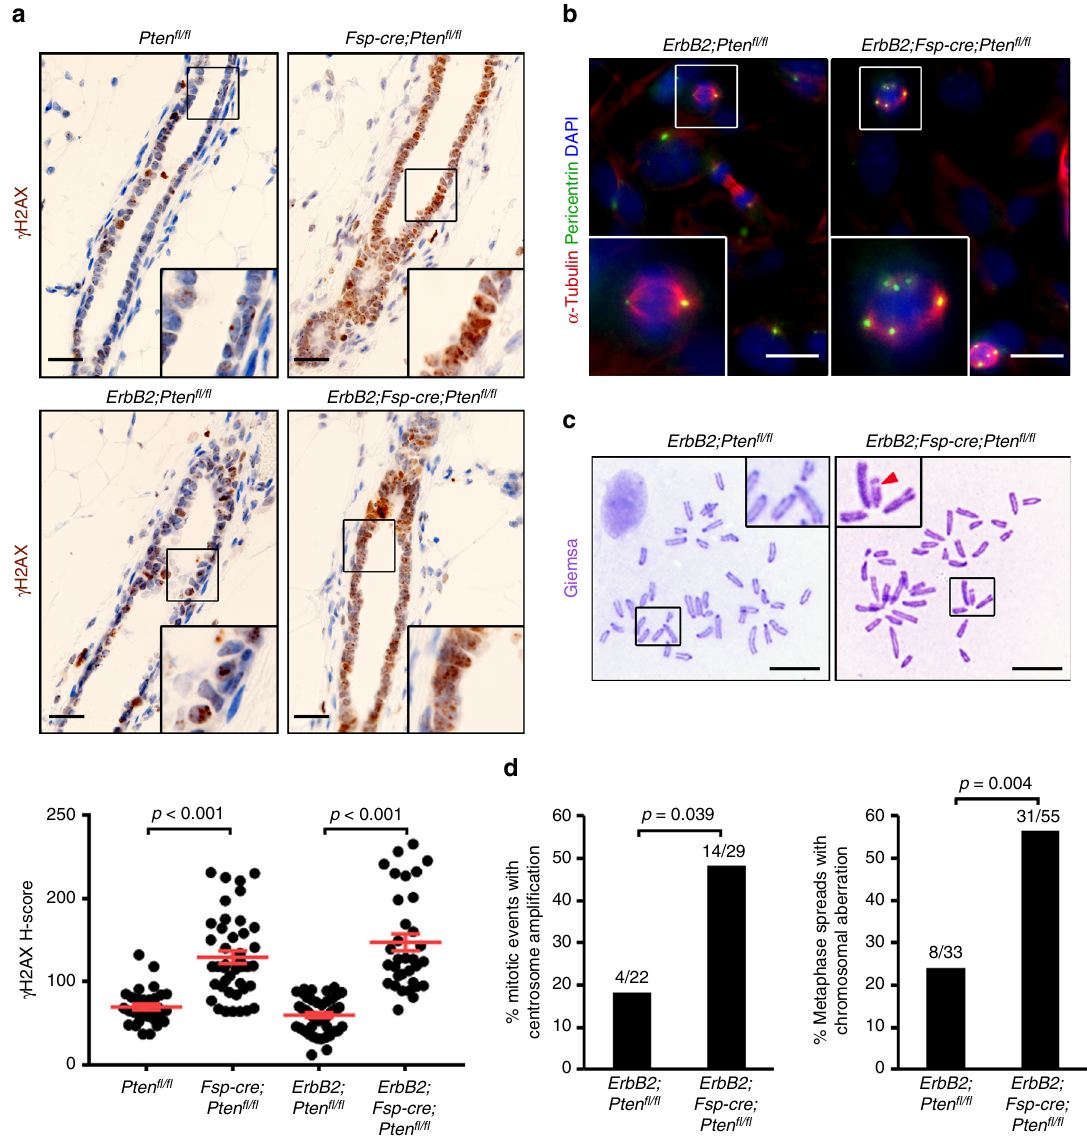
Fig. 2 Loss of stromal PTEN increases genomic instability in associated epithelium. a Representative γ -H2AX immunohistochemistry and quanti fi cation (mean ± s.e.m.) of mammary epithelium in Pten fl / fl , Fsp-cre;Pten fl / fl , ErbB2;Pten fl / fl and ErbB2;Fsp-cre;Pten fl / fl mice irradiated (6 Gy whole-body) and evaluated 6 h post-radiation. Both p values determined by unpaired, two-tailed Student ’ s t test ( Pten fl / fl n = 32 fi elds/3 mice, Fsp-cre;Pten fl / fl n = 42 fi elds/3